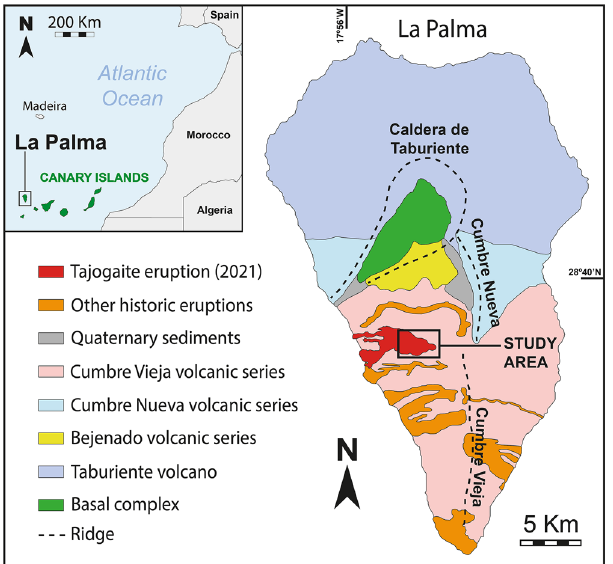
Figure 1. Geological map of La Palma. Location of the historical volcanic eruptions reported in the island, including the latest one which occurred in the Tajogaite area during 2021 that partially corresponds to the present work study